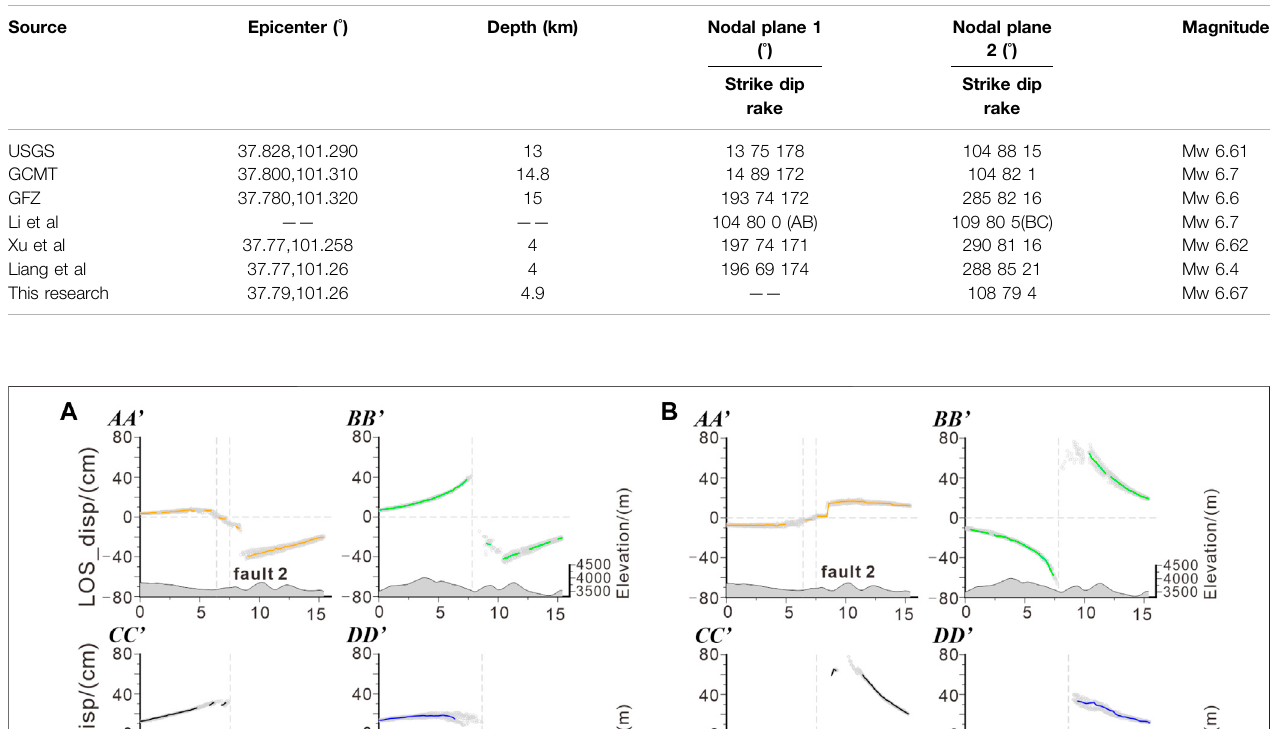
Frontiers in Earth Science |